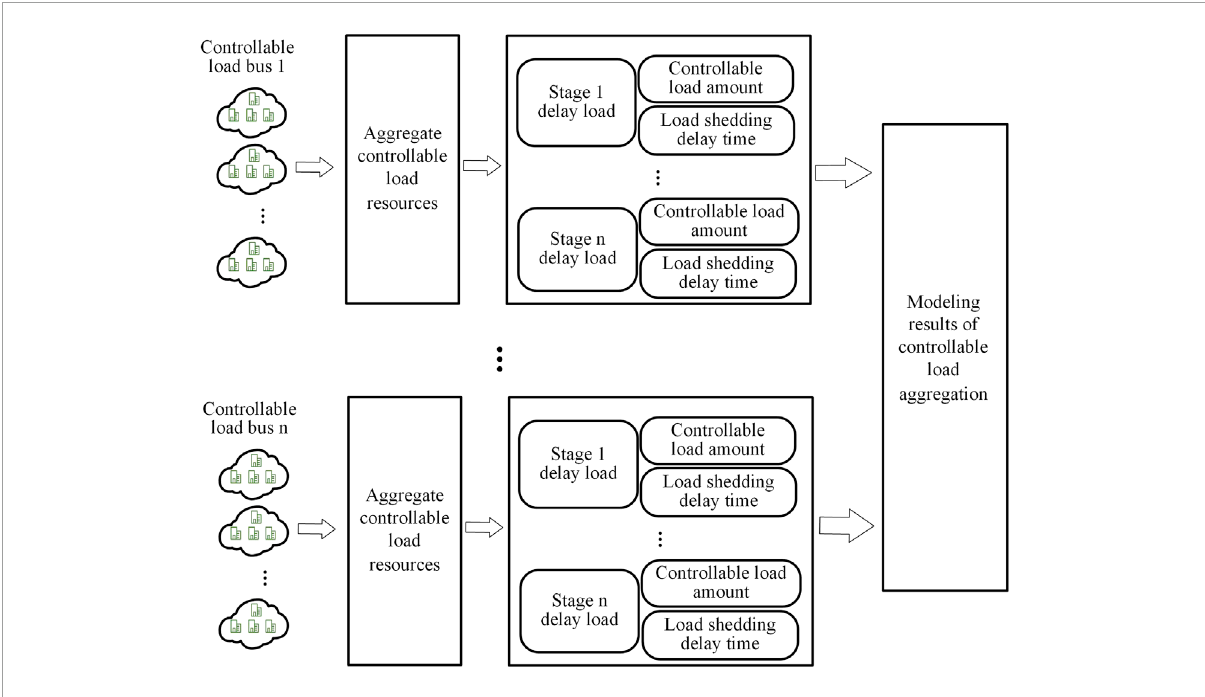
FIGURE 1 Controllable load aggregation modeling